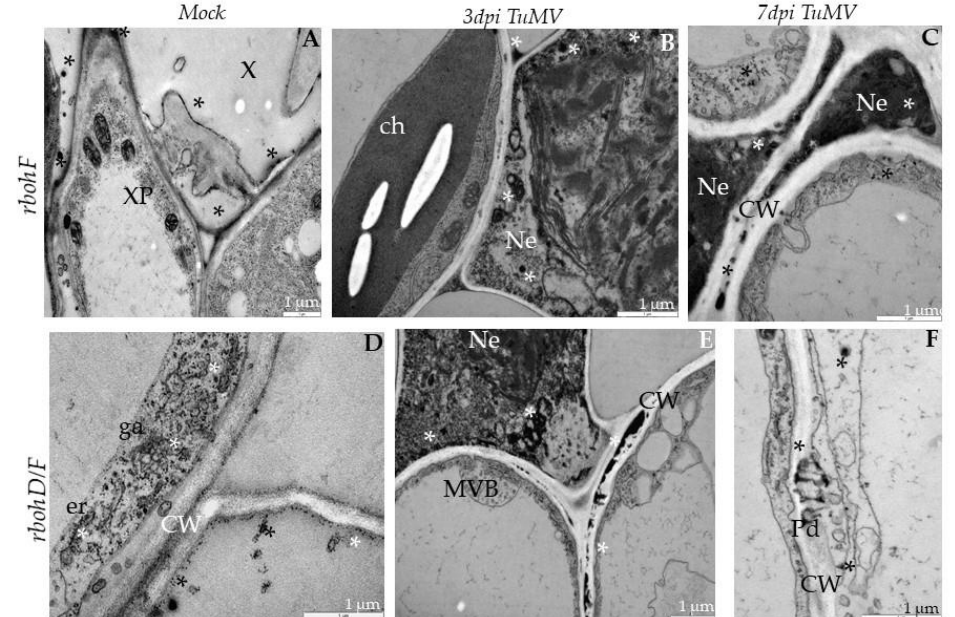
Figure 13. H 2 O 2 detection in rbohF and rbohD/F mock-inoculated leaf tissues ( A , D ) and 3 ( B , E ) and 7 days ( C , F ) post-TuMV inoculation examined under TEM. ( A ) Cerium perhydroxide precipitates (*) in cell wall and apoplast between cell wall and plasmalemma in rbohF mock-inoculated xylem tracheary elements (X). XP—xylem parenchyma. ( B ) H 2 O 2 (*) along membranous structures in necrotized (Ne) palisade mesophyll cell with destructed chloroplasts in rbohF . ( C ) H 2 O 2 (*) in dark necrotized (Ne) protoplast of phloem cells and in the cytoplasm of non-necrotized phloem parenchyma cells in rbohF . CW—cell wall. ( D ) H 2 O 2 staining (*) along the cell wall (CW) and endoplasmic reticulum (er) in rbohD/F mock-inoculated spongy mesophyll cells. ga—Golgi apparatus. ( E ) H 2 O 2 (*) along the cell wall (CW) and membranous structures of necrotized (Ne) rbohD/F spongy mesophyll cell. MVBs—multivesicular bodies; CW—cell wall. ( F ) H 2 O 2 (*) in plasmodesmata (Pd) and in cytoplasm around in rbohD/F mesophyll cell.